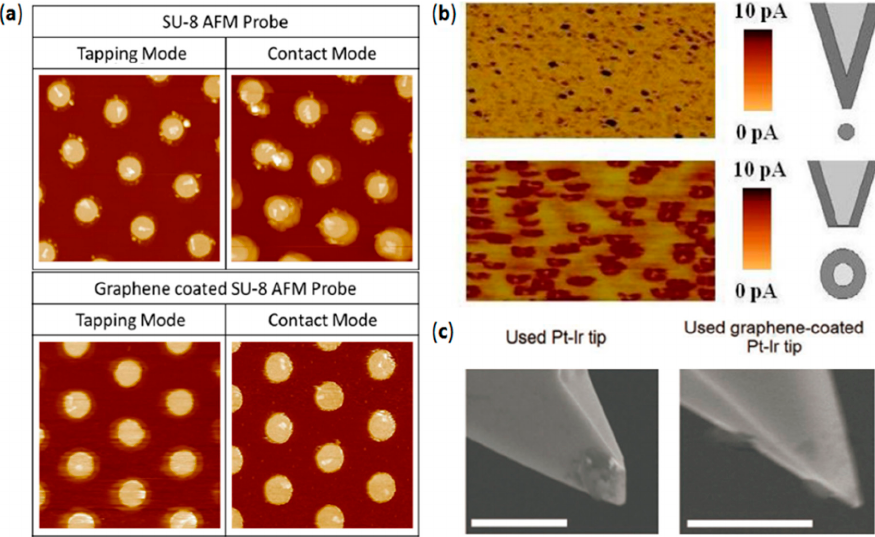
Figure 8. Mechanical exploration of graphene coated AFM compared with uncoated ones. ( a ) Topographic images collected by both tapping mode and contact mode on the sample of Ag/SiO 2 . Reproduced with permission from [26], copyright American Chemical Society (2013); ( b ) 400 nm × 250 nm current maps of HfO 2 /SiO 2 stack using a new (top) and worn-out commercial PtIr AFM conductive tip (bottom), the schematic in the right side represents the degree of wearing of tips; ( c ) SEM images indicate the degree of damage of the PtIr tip with and without graphene coating after use. The scale bars are 5 µ m (left) and 3 µ m (right), respectively. Reproduced with permission from [24], copyright Wiley-VCH